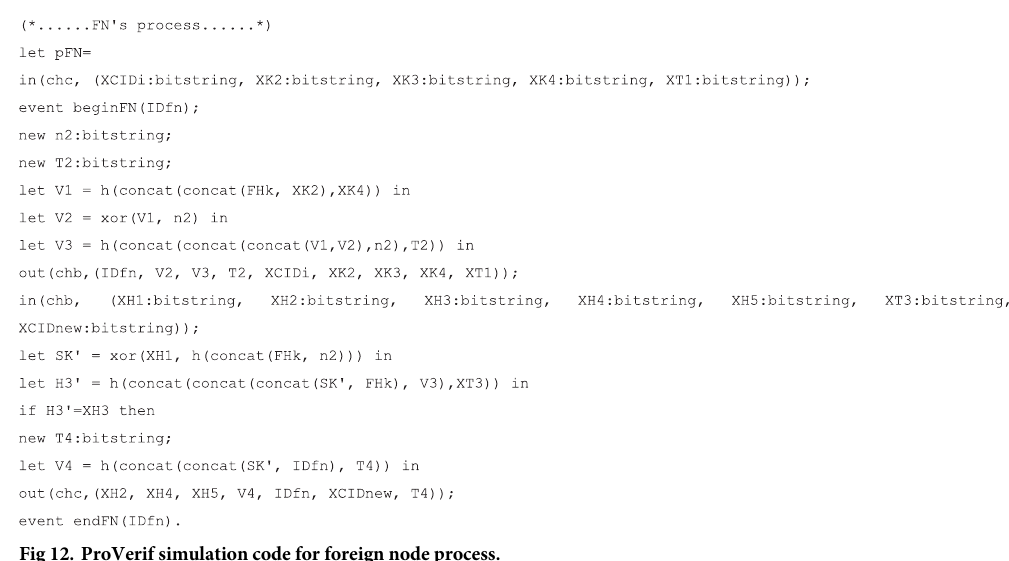
Fig 12. ProVerif simulation code for foreign node process.